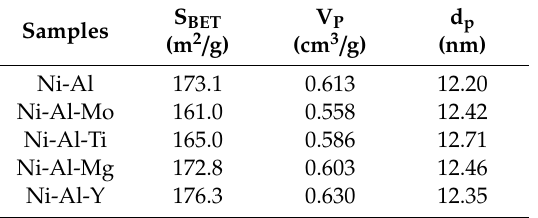
Table 1. Textural properties of Ni-Al-x (x = 0, Mo, Ti, Y, and Mg) catalysts.